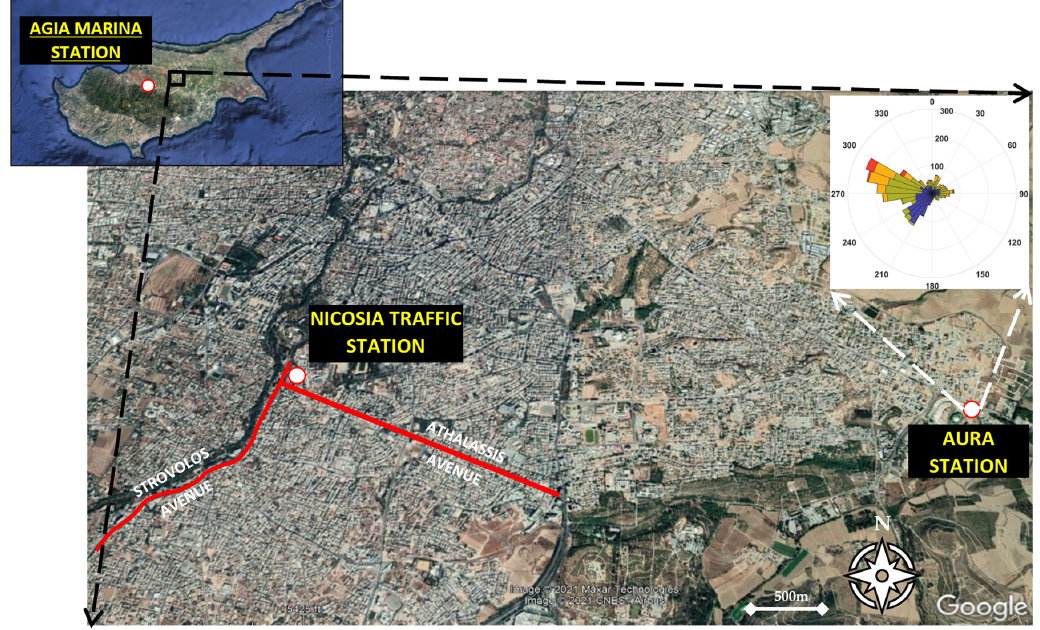
Figure 1. Google Earth image depicting the different locations of stations and the two avenues. Data from the AQMSs network of the Department of Labour Inspection, Air Quality, and Strategic Planning, Republic of Cyprus, were also used. Specifically, measurements were used from the background station of Agia Marina Xyliatou—AGM Station—which is far from anthropogenic activities (rural background station), as well as from the Nicosia traffic station—NicTr Station—which is close to busy traffic arteries (urban traffic station) (Figure